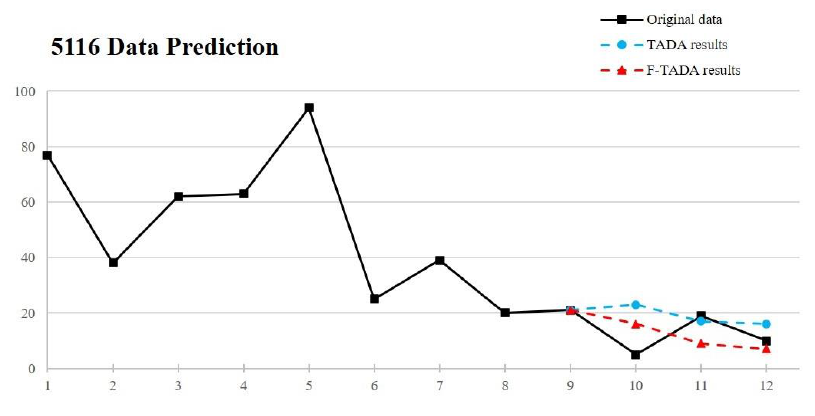
Figure 10. Results of 5116 data.